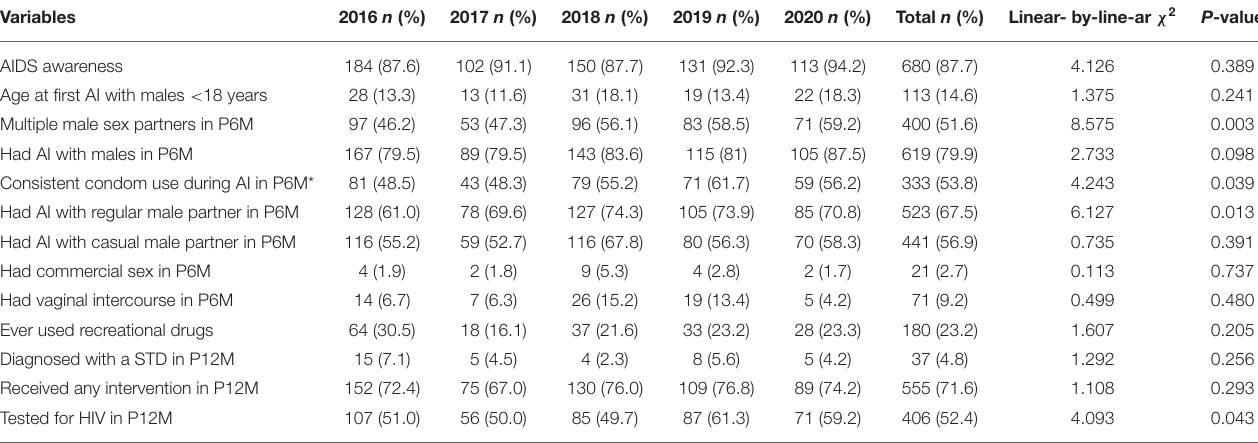
TABLE 2 | Trends in risk behavior and HIV testing among SMSM in Nanjing, China, 2016–2020.